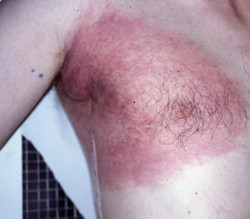
Inflammatory axillary nodal recurrence from cutaneous melanoma.